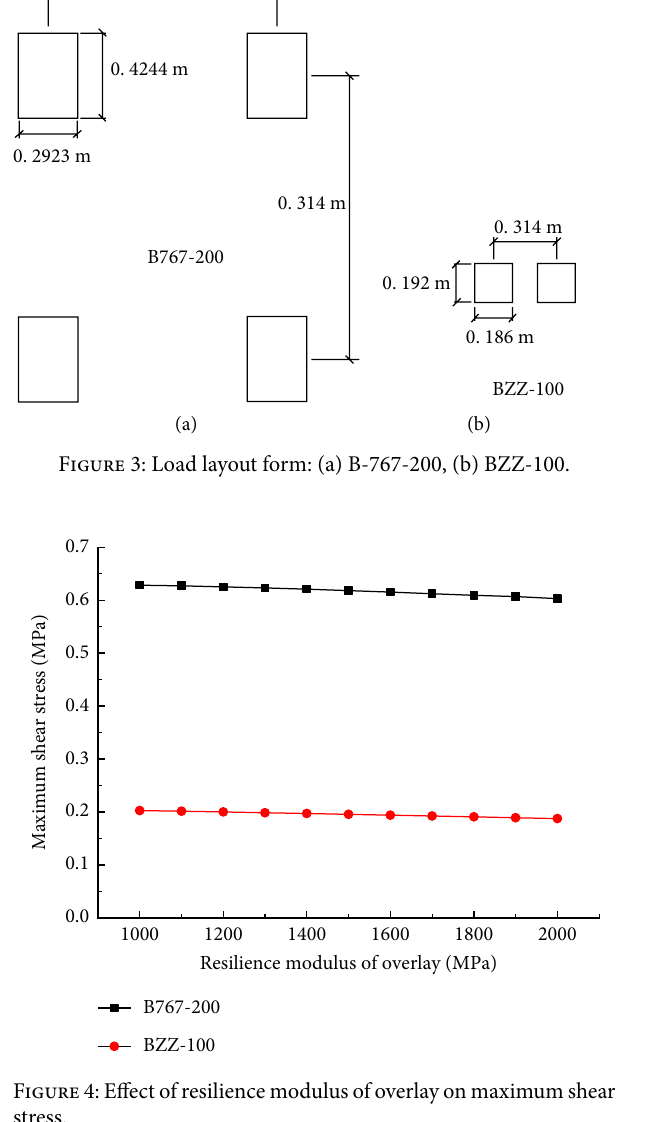
Figure 6: Effect of horizontal force coefficient on maximum shear stress of overlay.